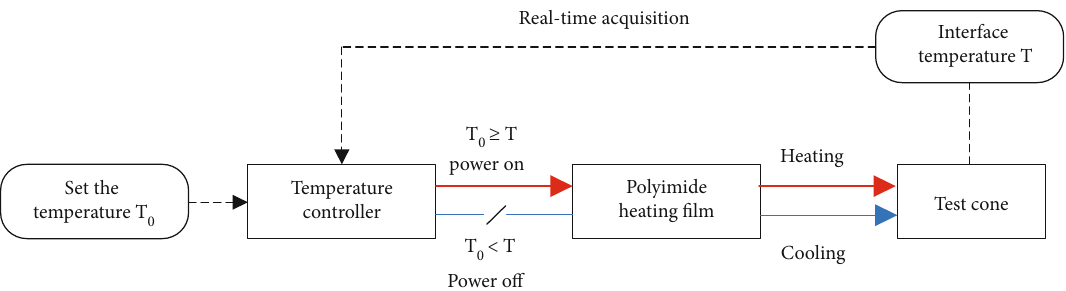
Figure 5: Operation principle of the interface temperature control.